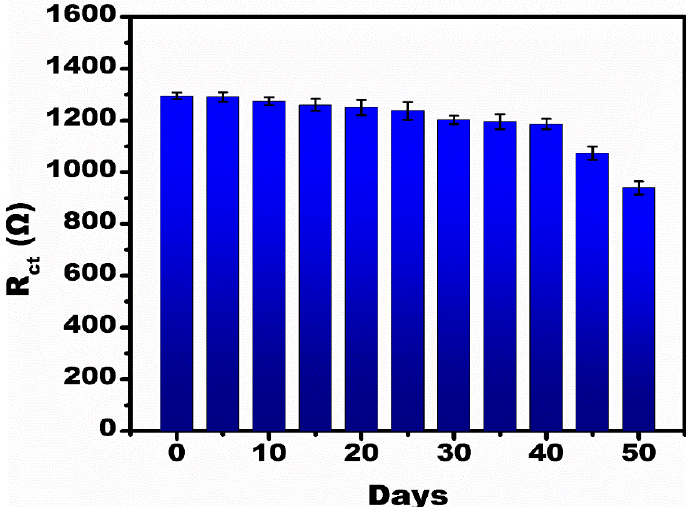
Figure 7. Stability analysis for the developed sensor at 1 µ M PT concentration tested at intervals of 5 days up to 50